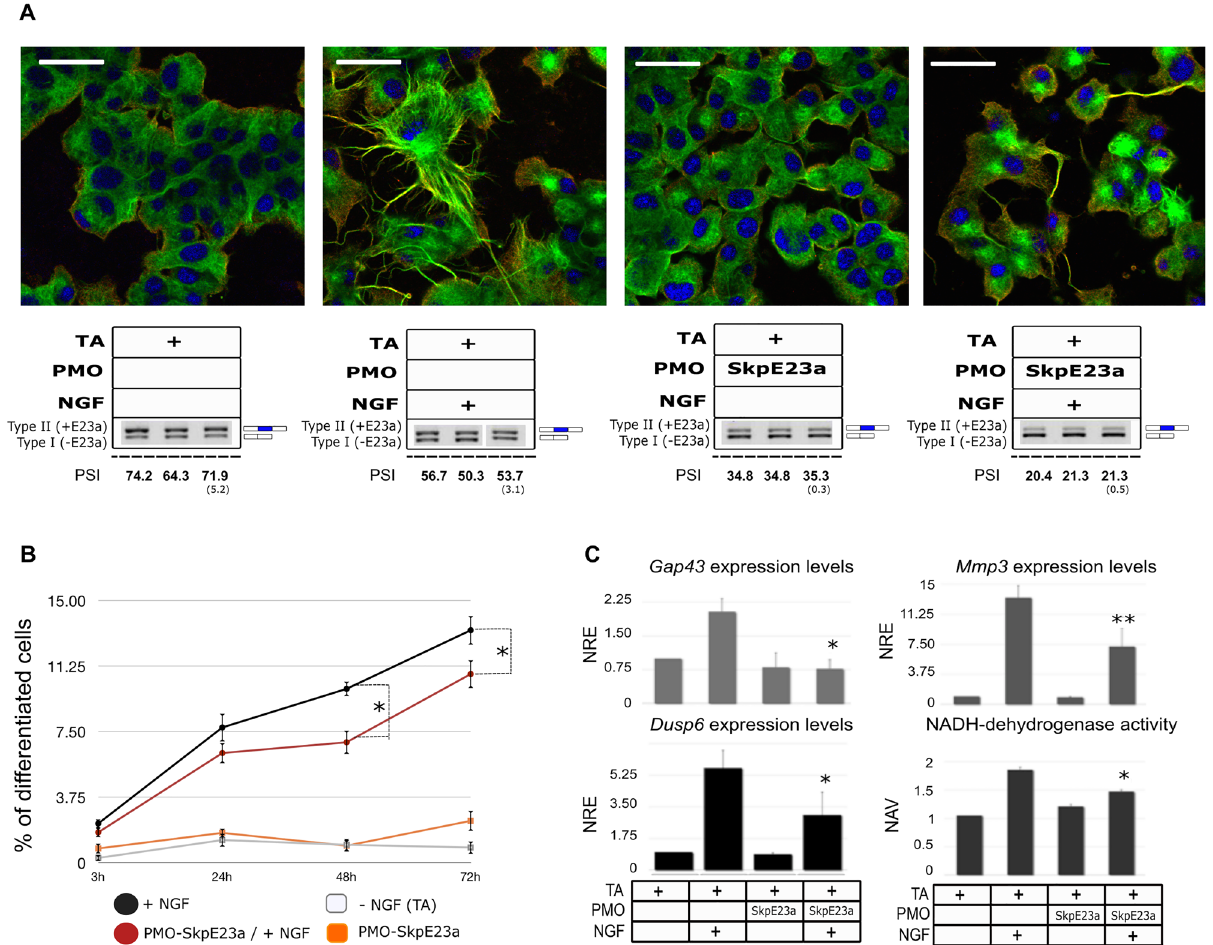
Figure 4. Impact of forcing E23a skipping using PMO-SkpE23a on NGF-induced PC12 neuronal differentiation. ( A ) Top: Representative images of a double immunofluorescent staining of NGFR (red) and α-tubulin (green) of PC12 cells after 72 h at different experimental conditions (scale bar = 40 μm). Bottom: Box specifying the different experimental conditions and the type II/I isoform expression ratio measured by RT-PCR. E23a splicing was quantified as the percent spliced-in (PSI) (standard deviation in parentheses). Supporting whole gel image can be found in Supplementary Fig. S4. ( B ) Time course analysis of the percentage of differentiated cells per field for each experimental condition. Each point represents the Mean ± SEM. * P < 0.05, paired t -test versus cells treated only with NGF. ( C ) Expression of the neuronal differentiation markers Dusp6 , Gap43 , Mmp3 analyzed by RT-qPCR and the enzymatic activity of NADH-dehydrogenase at the different experimental conditions set. NRE: Normalized Relative Expression ( Rpl29 and Rpl19 were used as reference genes). NAV: Normalized Absorbance Values. Bars indicate Mean ± SEM. * P < 0.05, ** P < 0.01, paired t -test versus cells treated only with NGF. TA: transfection